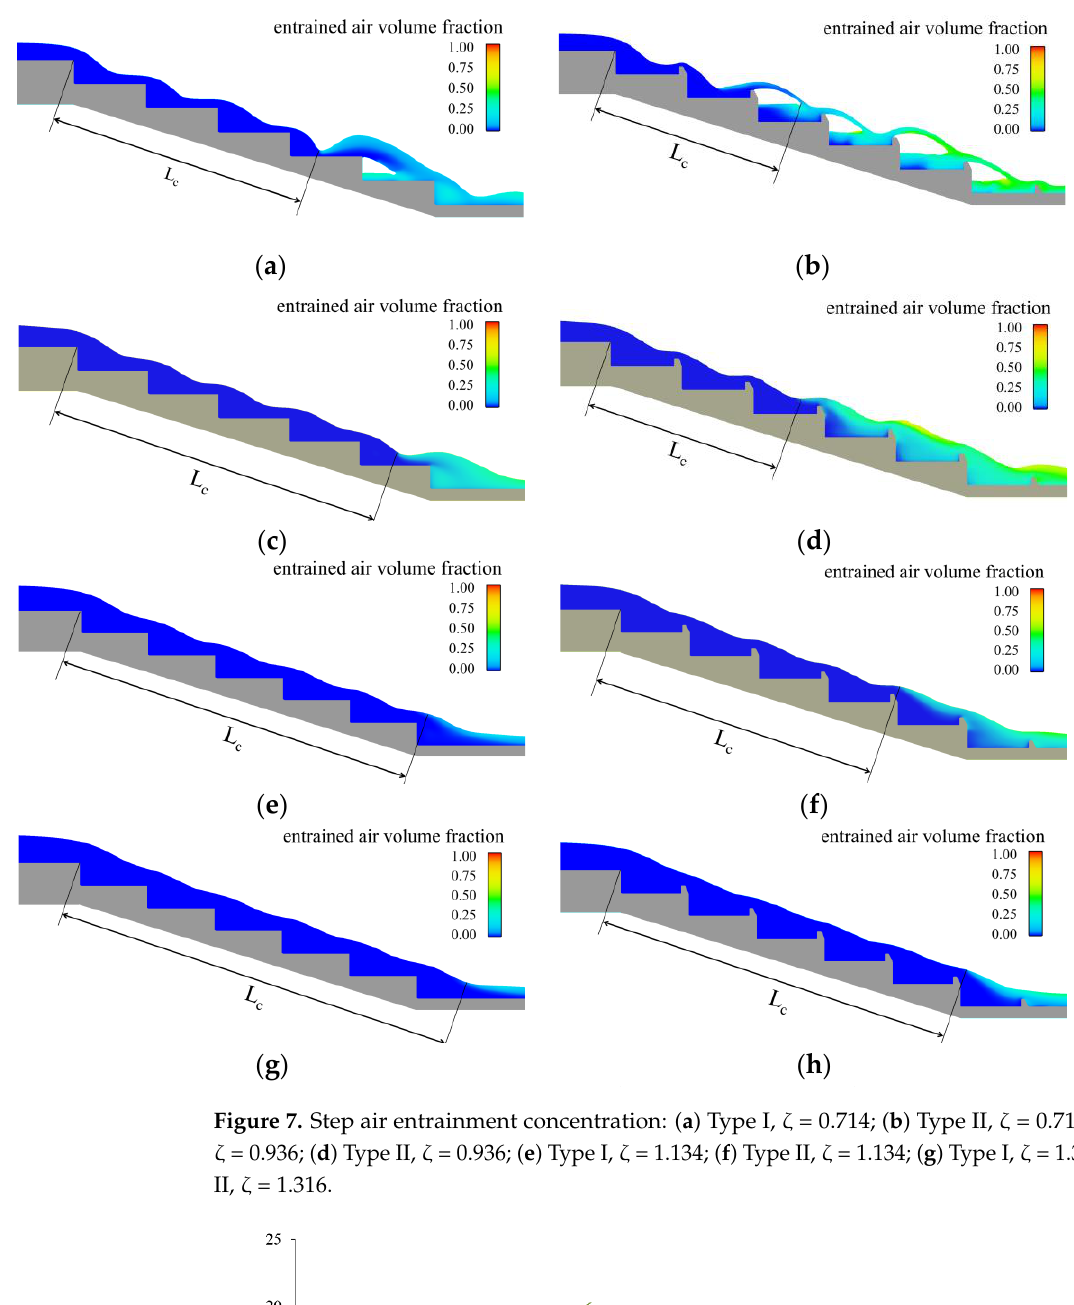
( b ) Figure 5. Comparison of simulated and experimental water depth: ( a ) Type I; ( b ) Type II. Figure 6. Water level diagram. 4. Results and Discussion 4.1. Air Entrainment Characteristics Water flows on the steps under the effect of strong turbulence and the boundary layer development to the water surface. When the water surface is broken, the water quality points leap away from the surface of the water, and then, due to gravity, move back down, involving a large amount of air, such that the water is mixed with gas. The aerated flow can reduce the cavitation damage of the step dissipator. Therefore, it is cru- cial to study the air entrainment characteristics of the step dissipator. Figure 7 compares the numerically simulated concentration of entrained air for type I and type II at different ζ. The figure shows that the initial air entrainment point of both types of step energy dissipator moves down with the increase in the relative critical wa- ter depth. This is in conformity with the results obtained by [11] . Under each ζ working